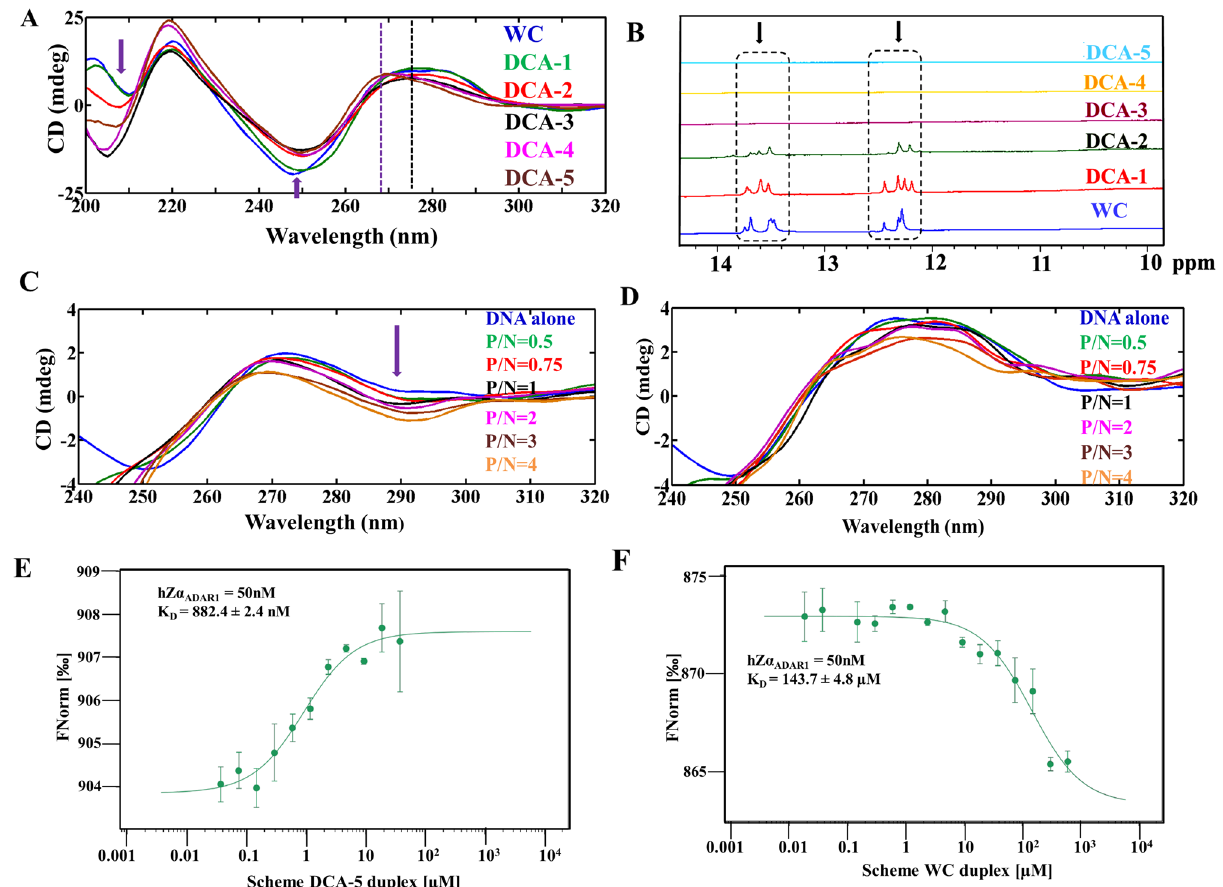
Figure 5. CD and NMR spectroscopic experiments reveal the increase in the extent of B–Z junction with the increasing number of A…A mismatch in CAA containing DNA sequence (Table 1). ( A) The CD spectra corresponding to CAA containing sequences that has 1–5 A…A mismatches. As the number of A…A mismatch in the DNA duplex increases, the B–Z junction formation is also increased. This is evident from the increasing and decreasing negative peak around 205 nm and 250 nm, respectively. The shift in the positive peak (black dotted lines) towards 268 nm (purple dotted lines) is also an indication of B–Z junction formation. The MATLAB 7.11.0 software (www.mathw orks.com) was used to plot the data. ( B ) Overlay of 1D proton NMR spectra of DNA duplexes that contain 1–5 A…A mismatches in the context of CAA sequence. The TopSpin 4.0.2 software (www.bruke r.com) was used for processing the NMR data. ( C ) Titration of hZα ADAR1 with d(CAA) 5 ·d(TAG) 5 duplex that has 5 A…A mismatches (Scheme DCA-5, Table 1). The appearance of the negative peak around 290 nm as a function of increasing hZα ADAR1 protein concentration is a clear indication of the B–Z junction formation. In contrast, the respective negative peak is absent in the ( D ) canonical WC DNA duplex (Scheme WC). The MATLAB 7.11.0 software (www.mathw orks.com) was used to plot the data. ( E , F ) The binding affinity between hZα ADAR1 and scheme DCA-5 (5 A…A mismatches) duplex measured using MST shows that the affinity between them is stronger ( E ) compared with the WC (0 A…A mismatch) DNA duplex ( F ). The law of mass action equation was used to fit the data using MO affinity software (www.nanot emper tech. com) to obtain the K D anti (minima regions IIa and IIb) , + syn… + syn (minima III) and anti… + syn (minima IV) glycosyl conformations are energetically favored (with a free energy value of 3 kcal/mol) for the mismatched adenines (Fig. 6C) with the standard deviation not more than 0.2 kcal/mol (Supplementary Fig. S9). The PMF further indicates the possibil- ity of transitions between 4 minima regions: two vertical transitions and two horizontal transitions. The vertical transitions are between the minima regions I and III (indicated by a) and, between minima regions II and IV (indicated by a ′ ). The horizontal transitions are between minima regions I and II (indicated by b) and between minima regions III and IV (indicated by b ′ ). However, the diagonal transitions, between I and IV (indicated by c) and between II and III (indicated by c ′ ) are unfavorable due to the presence of high energy barrier between the minima regions (Fig. 6C, indicated by cross symbol). This is due to the fact that the vertical and horizontal tran- sitions require change in the glycosyl conformation of just one of the mismatched adenines, whereas, the diago- nal transitions require the changes in the glycosyl conformations of both the adenines. Interestingly, in the MD simulation, anti… + syn (minima IV) , + syn…anti (minima I) and -syn…-syn (minima IIb) conformations are found to be preferred (Supplementary Figs. S1A–D, S2D) over the anti…anti glycosyl conformation. In fact, the initial anti…anti glycosyl conformation moves towards − syn… − syn conformation quite early during the simula-